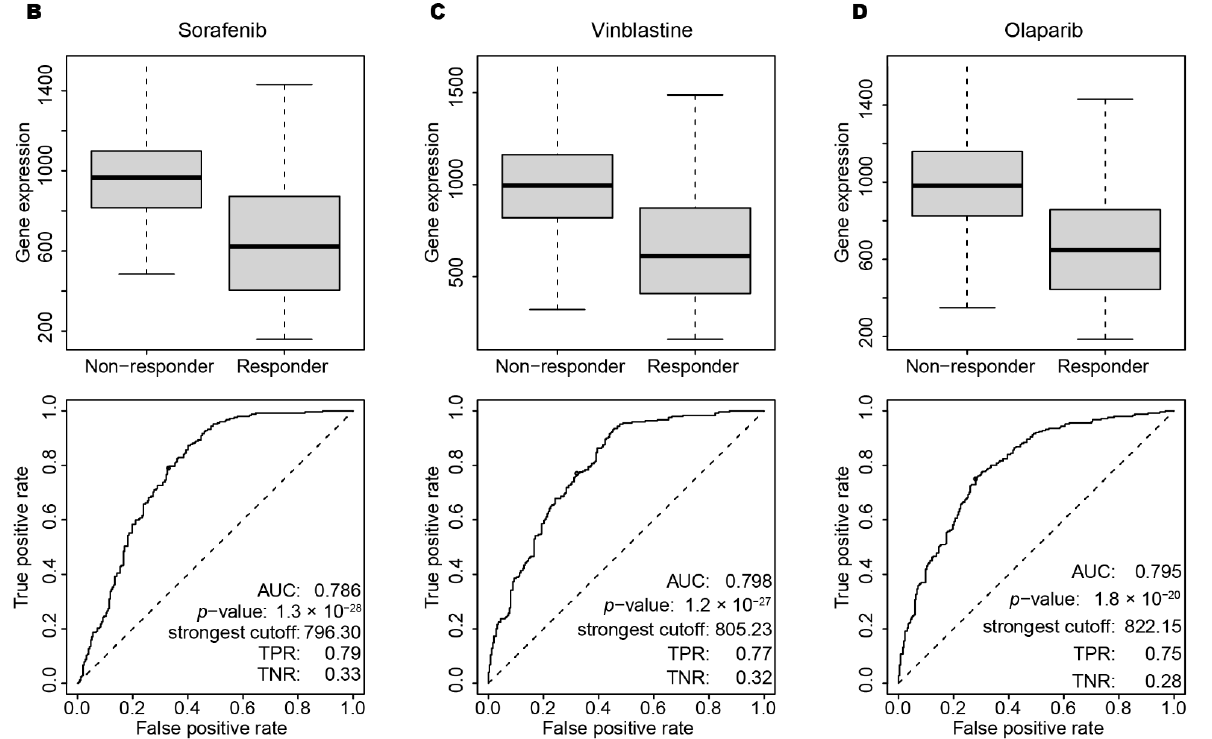
Figure 7. Drugs potency for targeting the 12 PRGs. ( A ) Bubble plot for the top 30 drugs associated with the PRG expression pattern. ( B – D ) The approved drug sorafenib, vinblastine, and Olaparib performance on cell lines derived from liver